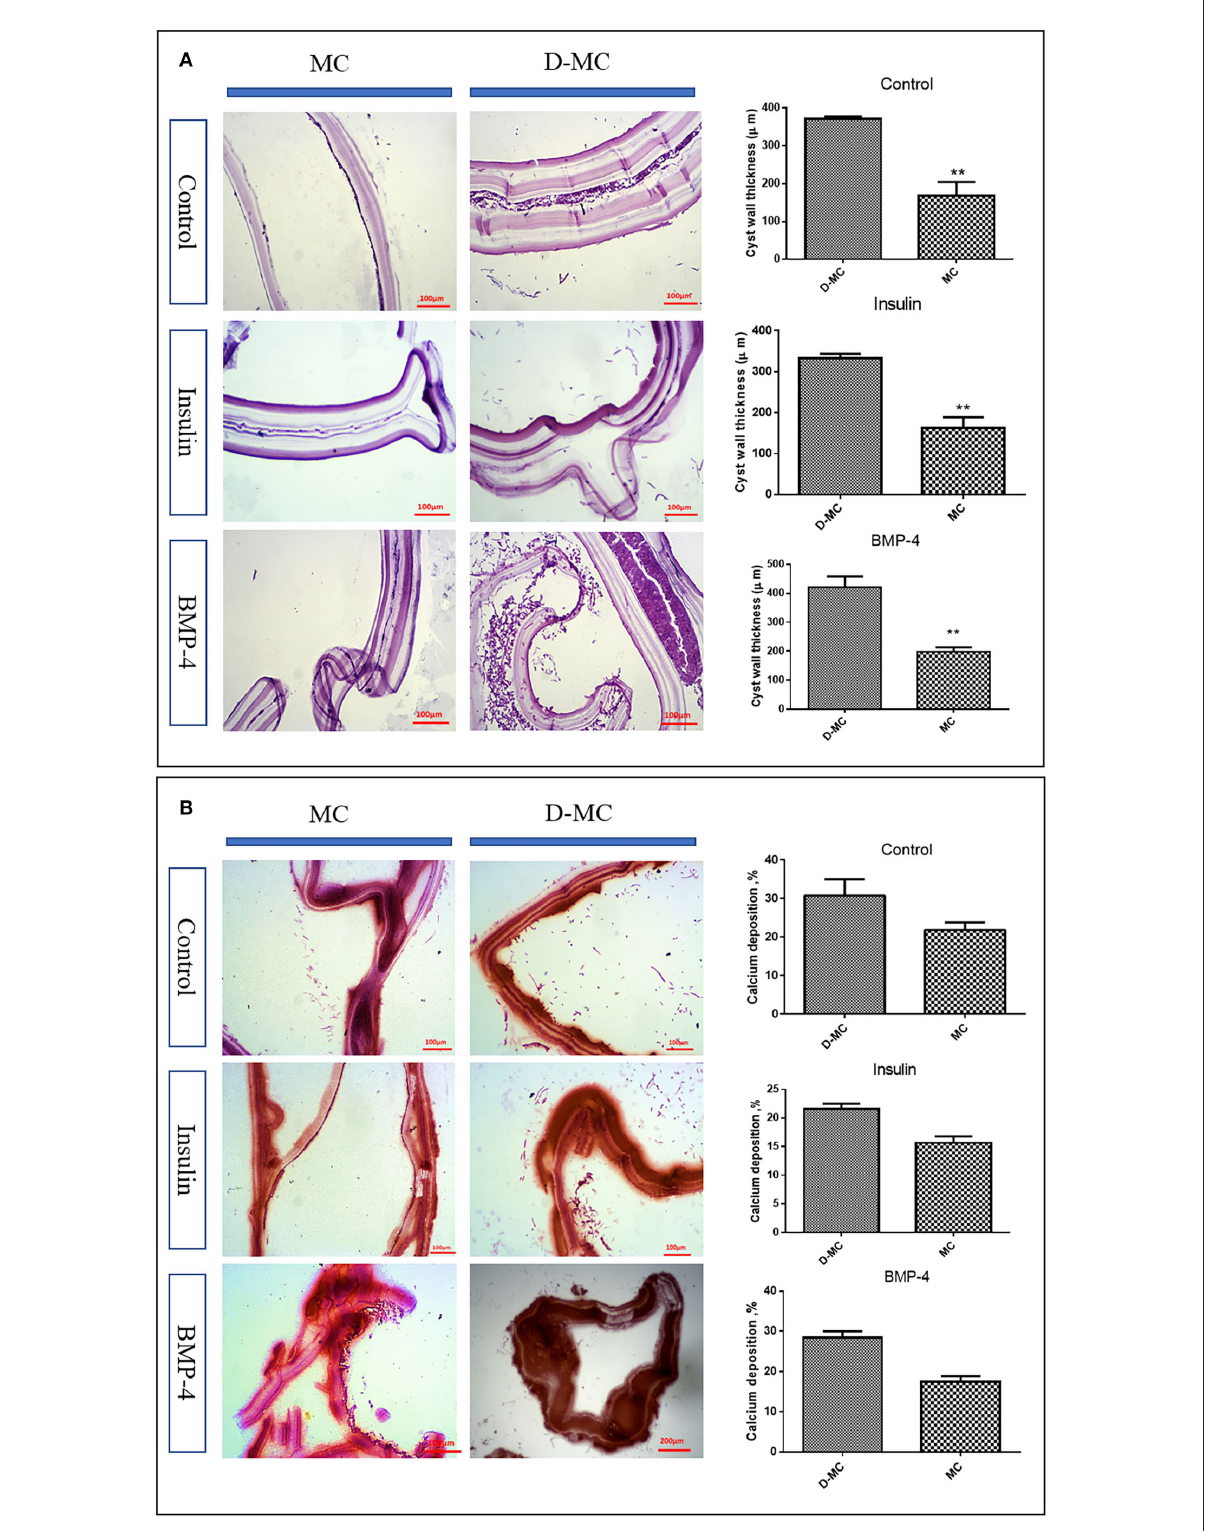
FIGURE3 In vitro histological changes in the microcysts of Echinococcus granulosus following treatment with insulin and BMP-4. (A) Changes in the laminated layer (LL) thickness of the microcysts of Echinococcus granulosus following treatment with insulin and BMP-4, Hematoxylin and Eosin (H&E) staining. MC, Microcyst; D-MC, Deformed microcyst. Bars show the mean ± standard deviation (SD). ** P < 0.005. (B) Calcium deposition changes in the microcysts of Echinococcus granulosus treated with insulin and BMP-4, Alizarin red staining. MC, Microcyst; D-MC, Deformed